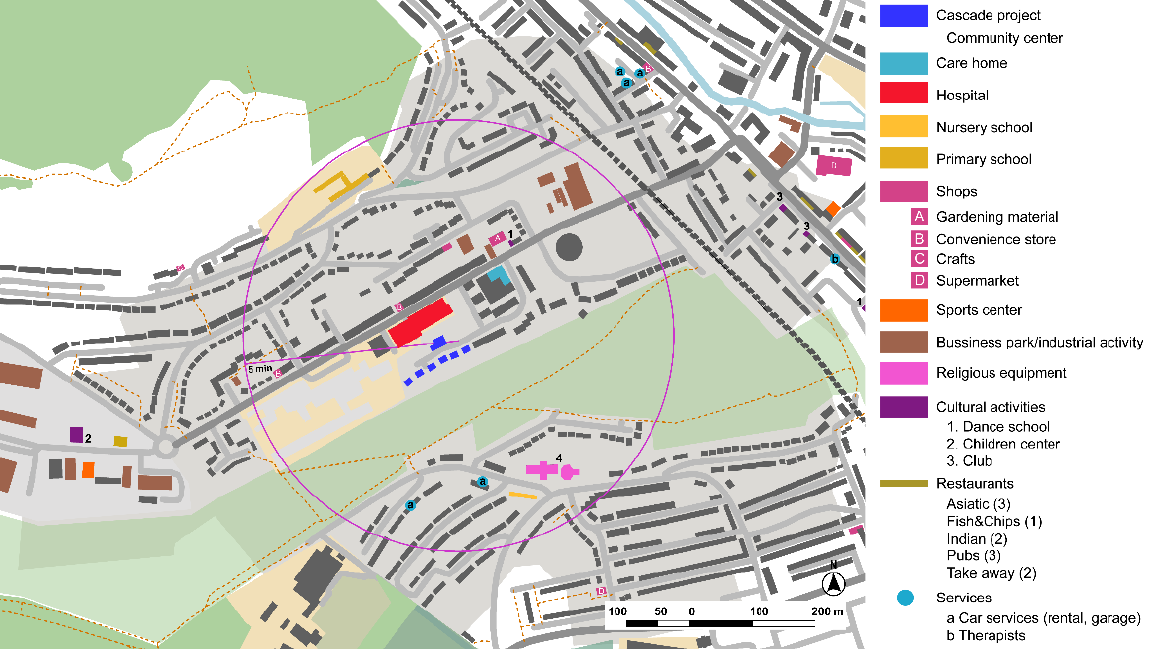
Figure 5. New Harmonia Village under CASCADE project and near surroundings, Dover, United Kingdom. Source: Own elaboration.